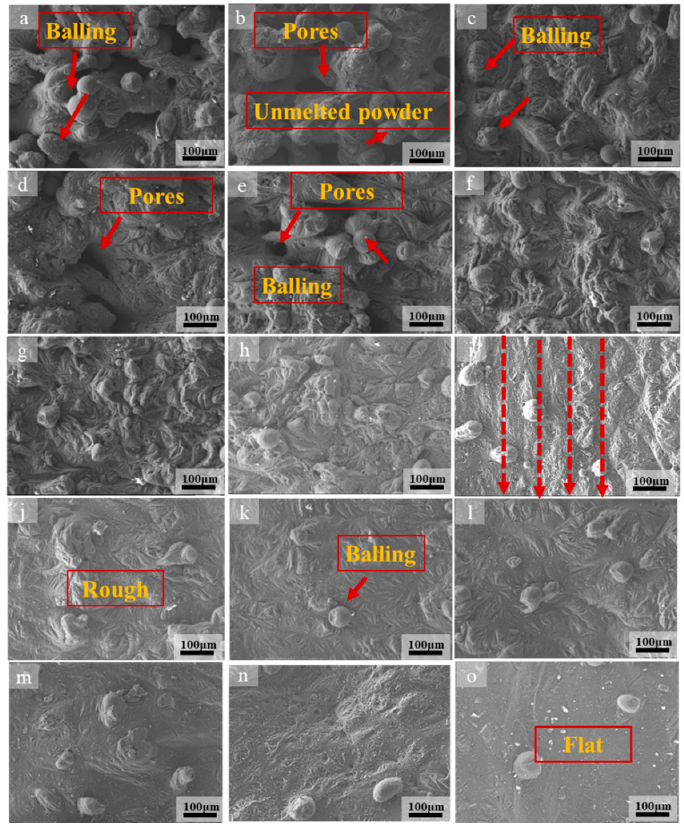
Figure 3. High-magnification scanning electron microscope (SEM) image surface of morphology of SLMed AZ61 magnesium alloy under different scanning speeds: ( a ) 950 mm/s, ( b ) 900 mm/s, ( c ) 850 mm/s, ( d ) 800 mm/s, ( e ) 750 mm/s, ( f ) 700 mm/s, ( g ) 650 mm/s, ( h ) 600 mm/s, ( i ) 550 mm/s, ( j ) 500 mm/s, ( k ) 450 mm/s, ( l ) 400 mm/s, ( m ) 350 mm/s, ( n ) 300 mm/s, and ( o ) 250 mm/s.